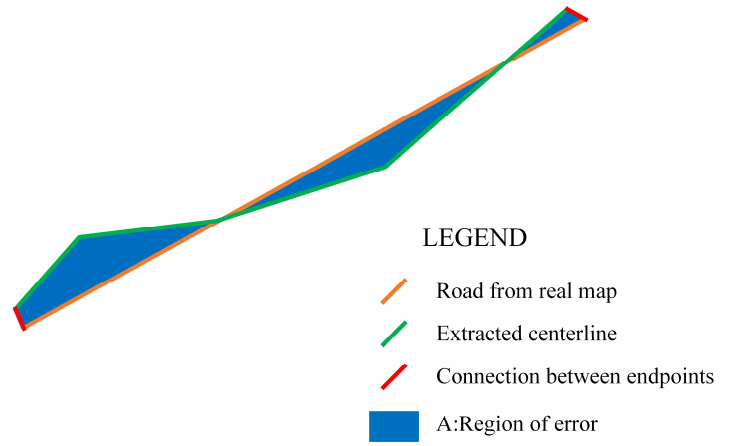
Figure 11. Distance calculation between real and extracted roads.